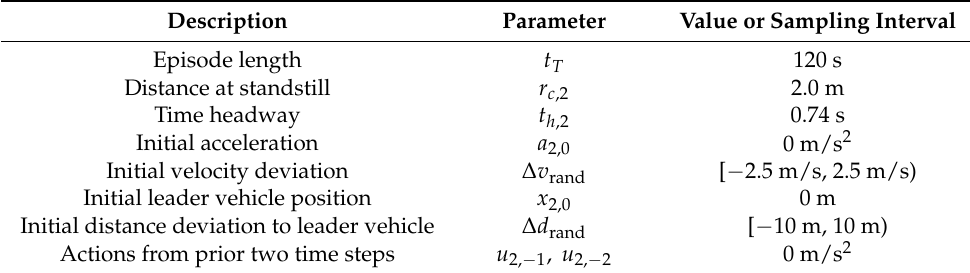
Table 4. Training setup and